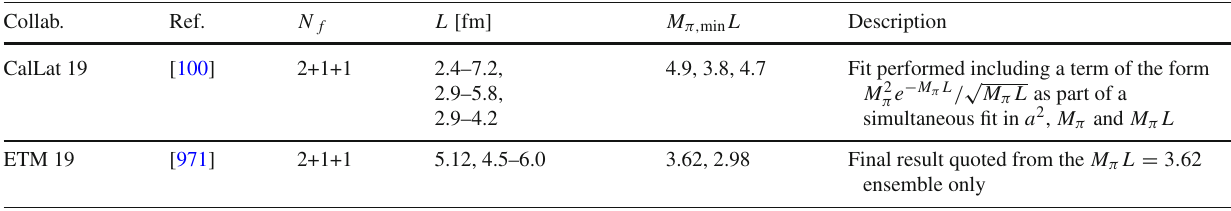
Table 178 Finite-volume effects in determinations of the isovector axial, scalar and tensor charges with N f = 2 + 1 + 1 quark flavours Collab.